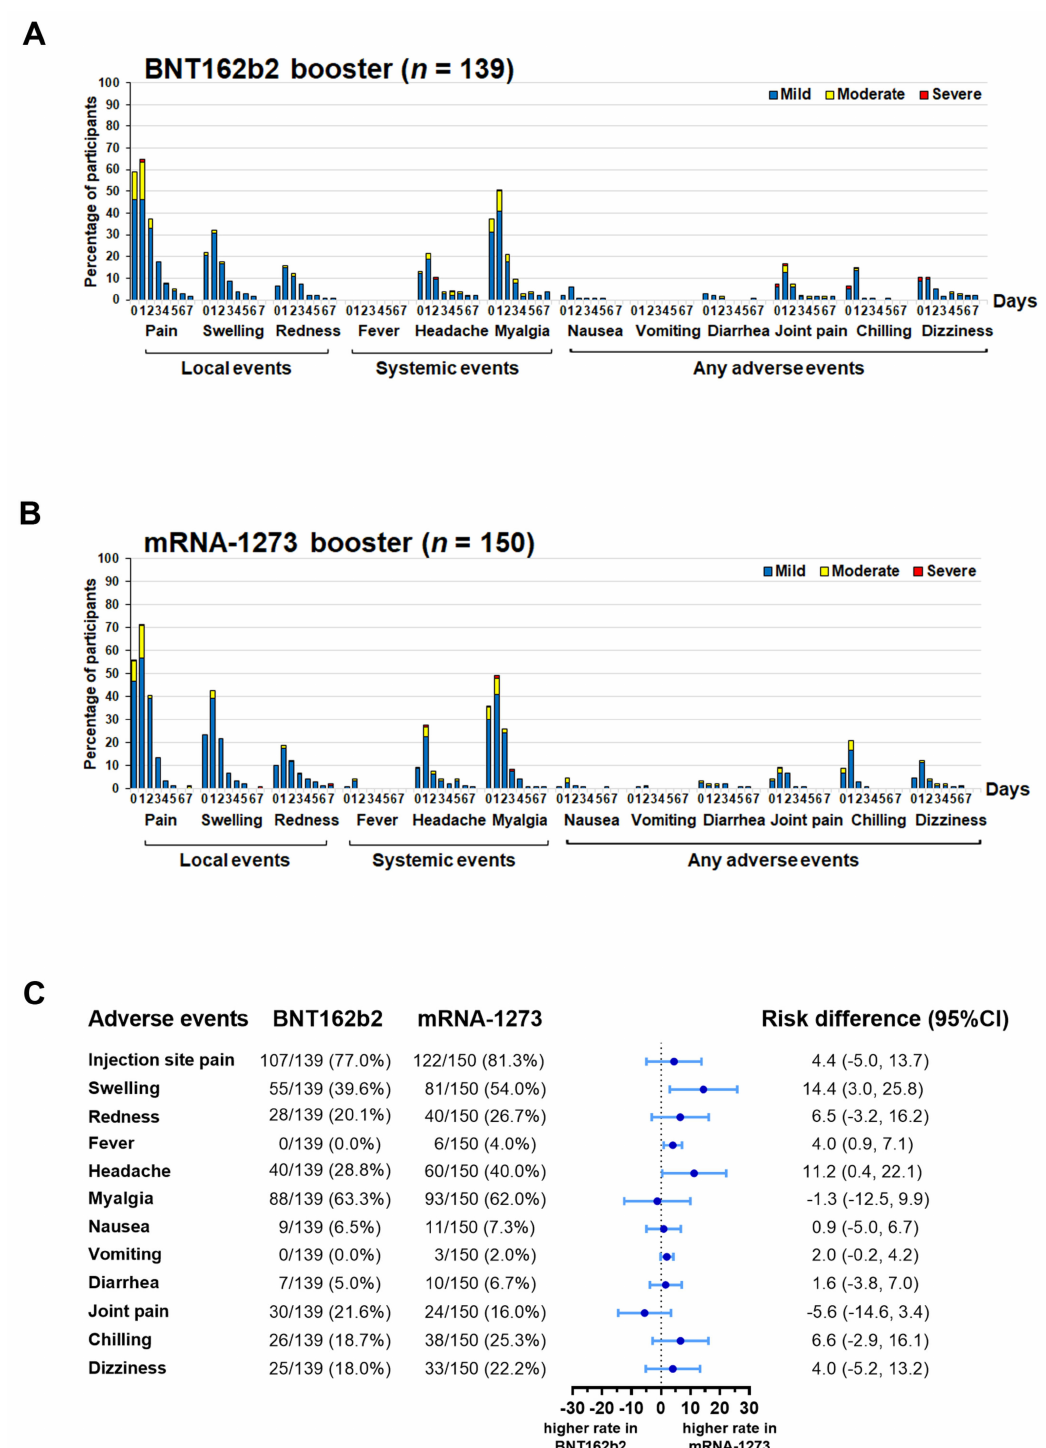
Figure 2. Overall reactogenicity of individuals who received a fourth dose of either BNT162b2 or mRNA-1273. The percentages of local, systemic, and any adverse events (AE) experienced within 7 days of receiving ( A ) BNT162b2 or ( B ) mRNA-1273. ( C ) Forest plots showing the incidences of each AE and the risk differences with 95% confidence intervals (95%